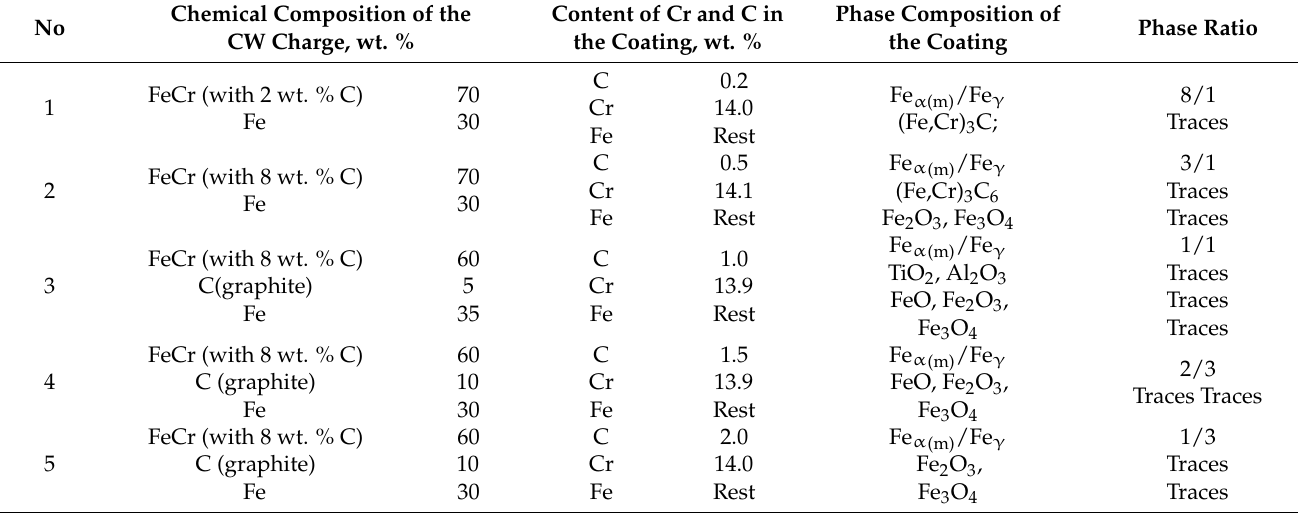
Table 1. Influence of the CW charge composition on the phase composition of the obtained